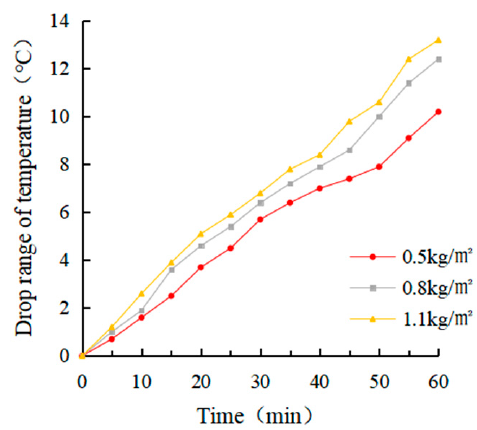
Figure 11. Surface cooling value diagram.